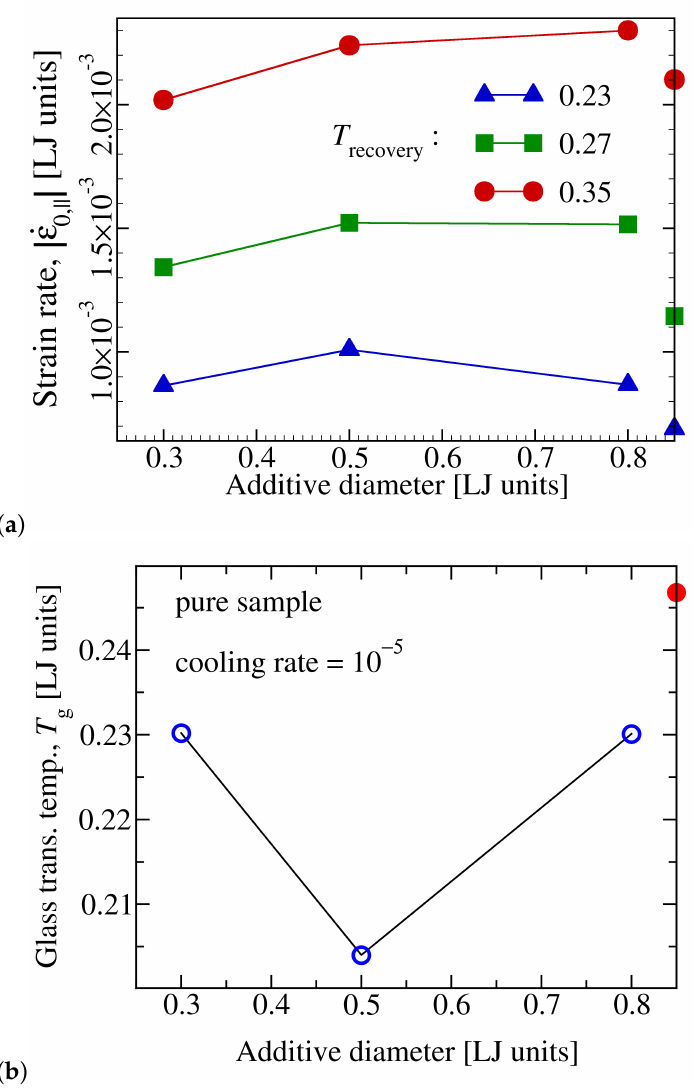
Figure 8. ( a ) Initial shape recovery rate versus σ SS for three values of recovery temperature as indicated and for a constant number concentration of φ s = 0.20. At the highest temperature shown here ( T recovery = 0.35), the rate of strain recovery is a monotonic function of σ SS but a non-monotonic trend develops for lower T recovery and becomes distinguishable at a temperature of T recovery = 0.23 < T g ( φ s = 0 ) ≈ 0.25. Filled symbols on the right vertical axis give the recovery rate of the pure sample at the corresponding T recovery . ( b ) The glass transition temperature, T g , obtained from cooling simulations (Figure 3) versus additive-diameter. In agreement with low- T data in panel ( a ), a non-monotonic effect is clearly visible here. All quantities are given in Lennard-Jones